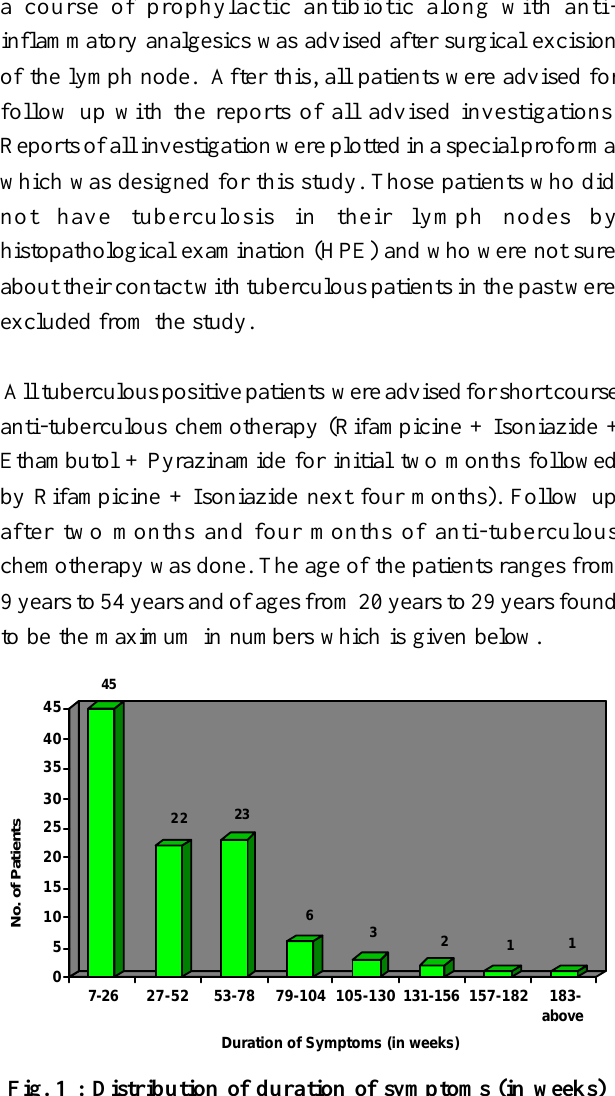
Fig. 1 : Distribution of duration of symptoms (in